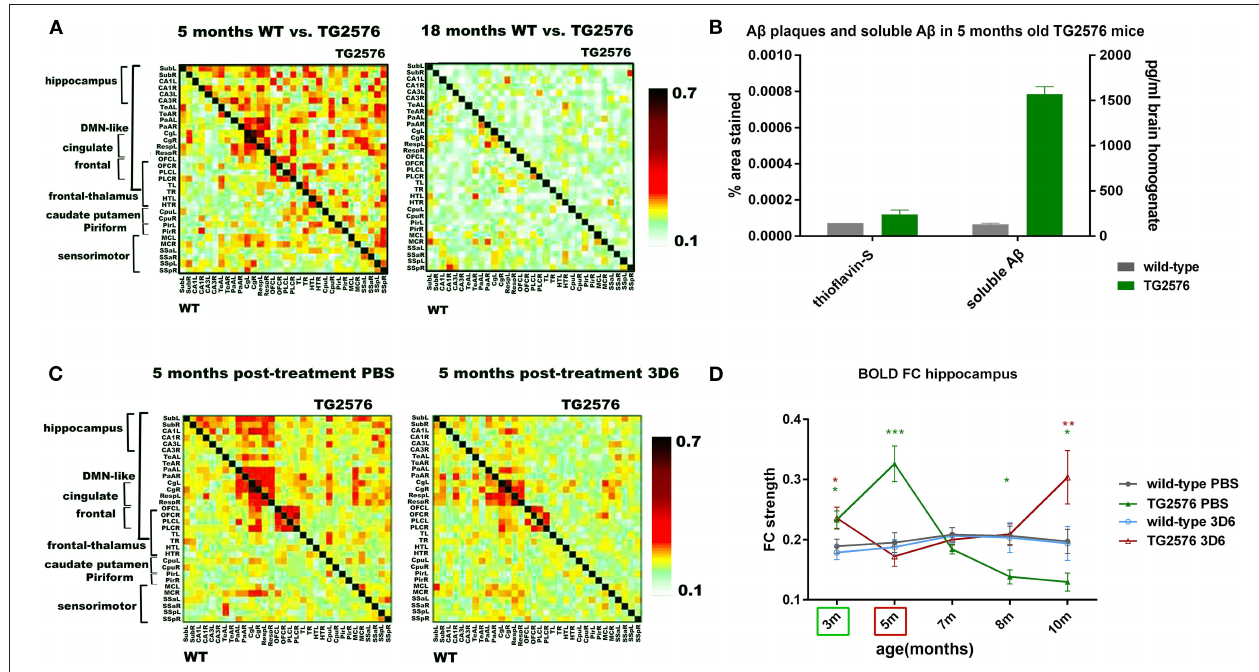
FIGURE 3 | Anti-amyloid beta (A β ) antibody treatment prevents early hyperconnectivity. (A) Mean BOLD FC matrices show z-transformed Pearson correlations between pairs of brain regions of wild-type (WT) (lower half of matrix) and TG2576 tg mice (upper half of matrix) at 5 and 18 months of age. At 5 months of age, TG2576 mice show hyperconnectivity in most brain regions, which evolves to decreased BOLD FC at 18 months of age. (B) 5 months old TG2576 mice show no A β plaques, as shown on the left Y-axis of the graph (% area stained by Thioflavin-S ± standard error). Soluble A β 42 is increased at 5 months of age, as shown on the right Y-axis (pg/ml A β 42 concentration ± standard error, measured by ELISA). (C) Chronic treatment with the anti-A β antibody 3D6 prevents BOLD hyperconnectivity in TG2576 mice. Mean BOLD FC matrices show z-transformed Pearson correlations between pairs of brain regions for saline-treated and 3D6 treated mice. (D) Graph shows evolution of hippocampal BOLD FC for saline-treated and 3D6 treated wild-type and TG2576 mice (FC ± standard error). Treatment started at 3 months (indicated by the green box) until 5 months (indicated by the red box). Five months after ending the treatment, BOLD hyperconnectivity in the hippocampus reoccurred in 3D6 treated mice, strongly suggesting a role of soluble A β in hyperconnectivity. Adopted from Shah et al. (2016c). * P value < 0.05; ** P value < 0.01; *** P value <